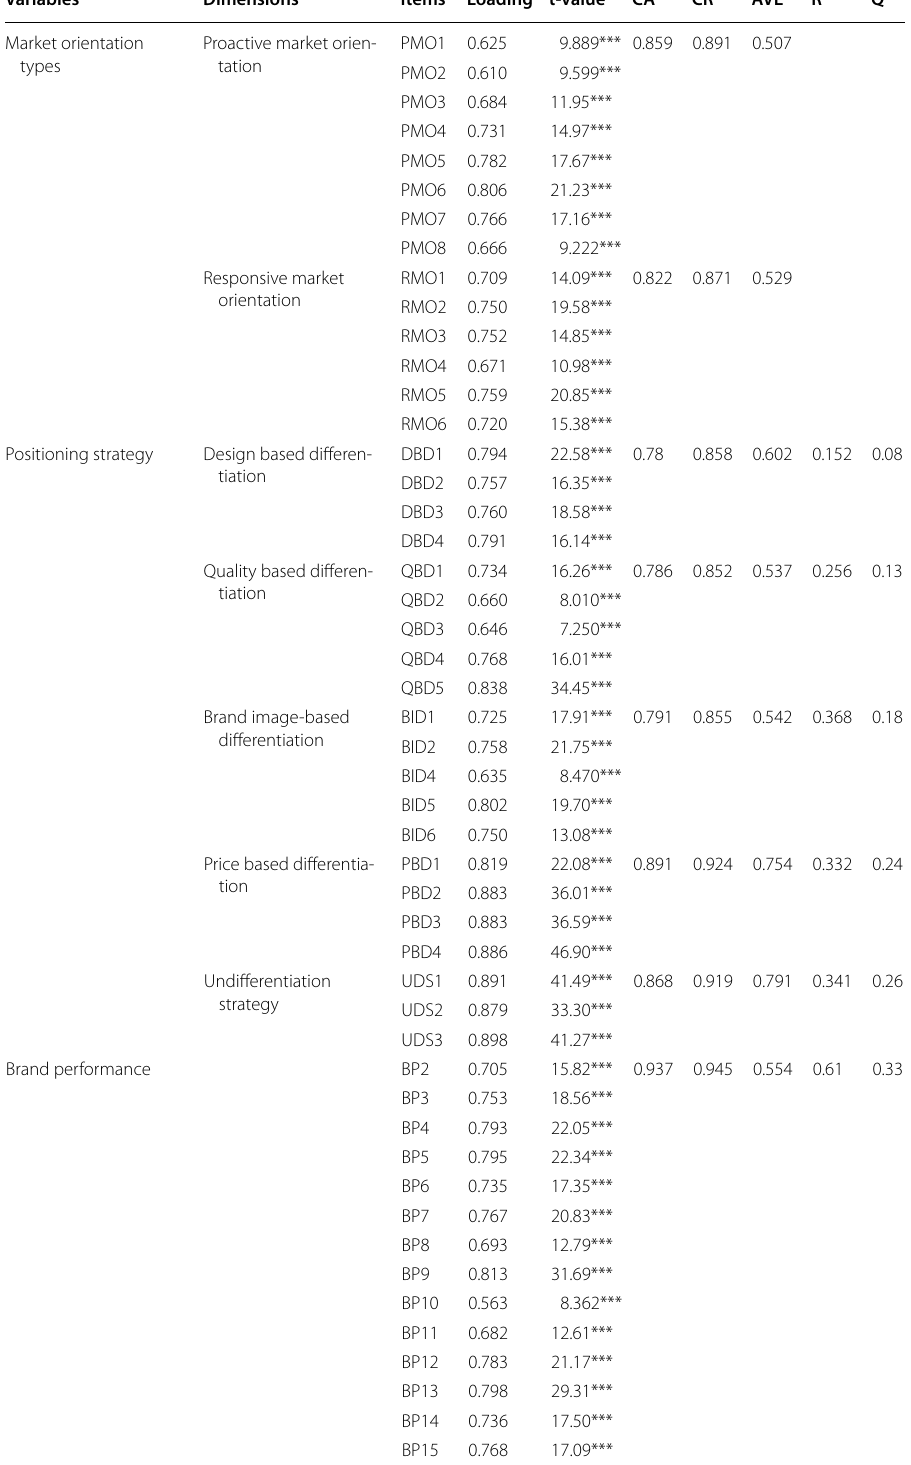
Table 1 Measurement properties Variables Market orientation